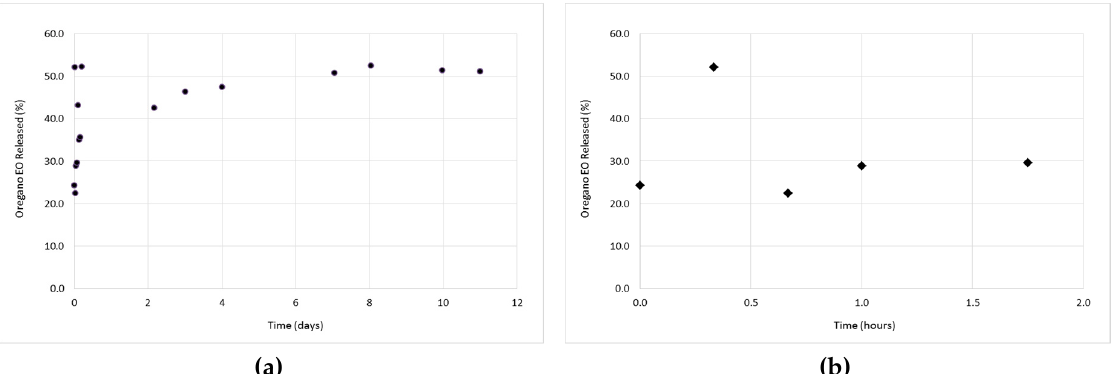
Figure 6. The release profile of the encapsulated oregano EO at 37 °C and pH 7.4, during 11 days ( a ), as well as at the first 1 h and 45 min of the experiment ( b ).